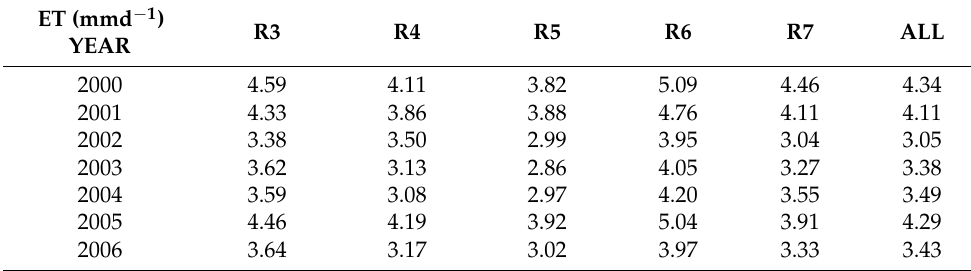
Table A5. ET (mmd − 1 ) from 2000–2020 shows the peak growing season (1 May to October 30) water use for each reach and the total weighted average in All reaches for each of the 21 years in the study and the average and standard deviation over the study period is provided in the last lines of the